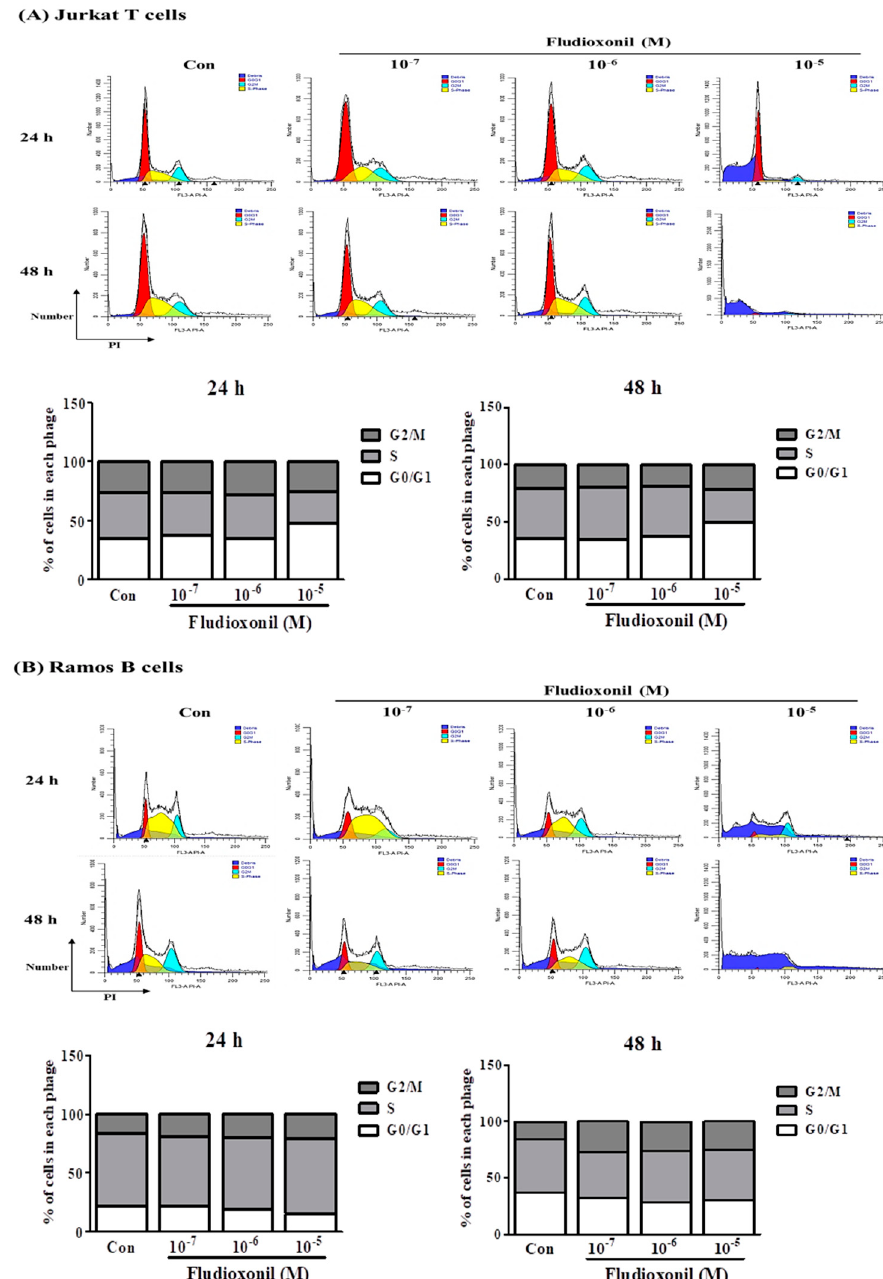
Figure 2. Cell cycle arrest of Jurkat T cells and Ramos B cells at the treatment of fludioxonil. ( A ) Jurkat T cells and ( B ) Ramos B cells histogram graph were representative cell cycle analysis results using flow cytometry. The cell cycle was analyzed by cell staining with PI. In the histogram results, the dark blue section indicates the debris of the cells, the red section indicates G0 / G1 phase, the yellow section indicates the S phase, and light blue indicates the G2 / M phase. FL3-A represents the intensity of PI and the y-axis represents the cell numbers. In the stacked bar graphs, the changes of G0 / G1, S, and G2 / M phase proportion of Jurkat T cells and Ramos B cells show the altered cell cycle by fludioxonil.